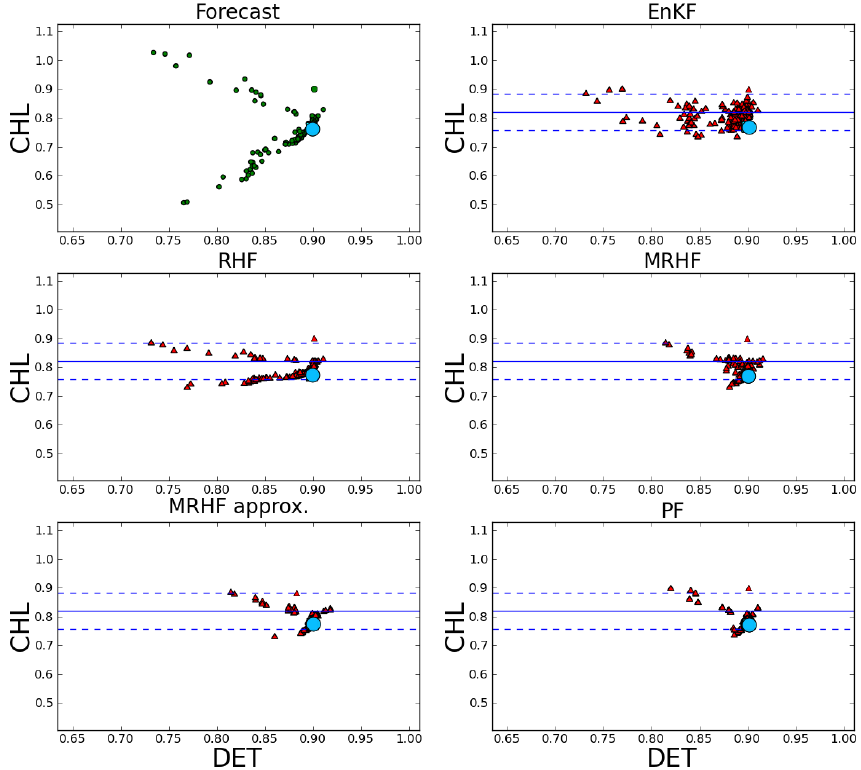
Figure 14. Same as Fig. 13 but on the chlorophyll (CHL)–biogeochemical detritus (DET)